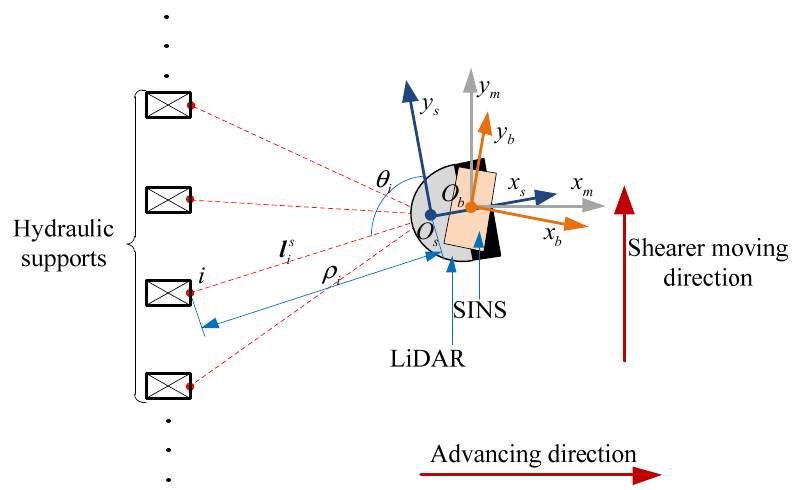
Figure 4. Installation relationship between the SINS and LiDAR.